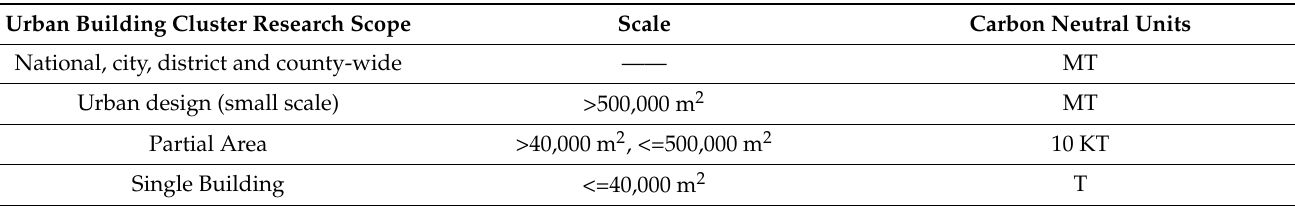
Table 3. Urban Building Cluster Research